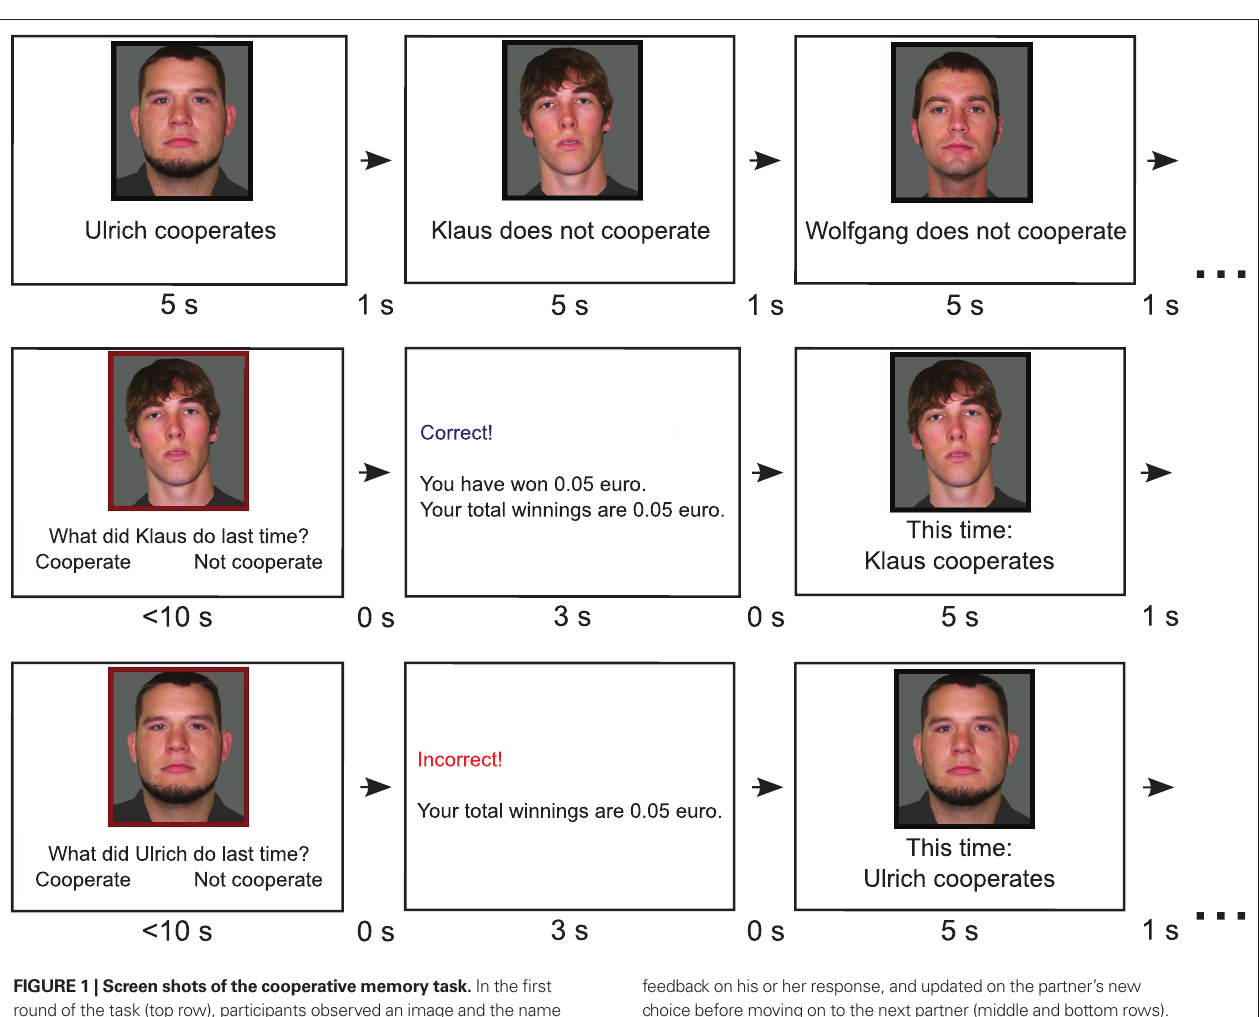
feedback on his or her response, and updated on the partner’s new choice before moving on to the next partner (middle and bottom rows). Numbers below screens give presentation times for screens and between